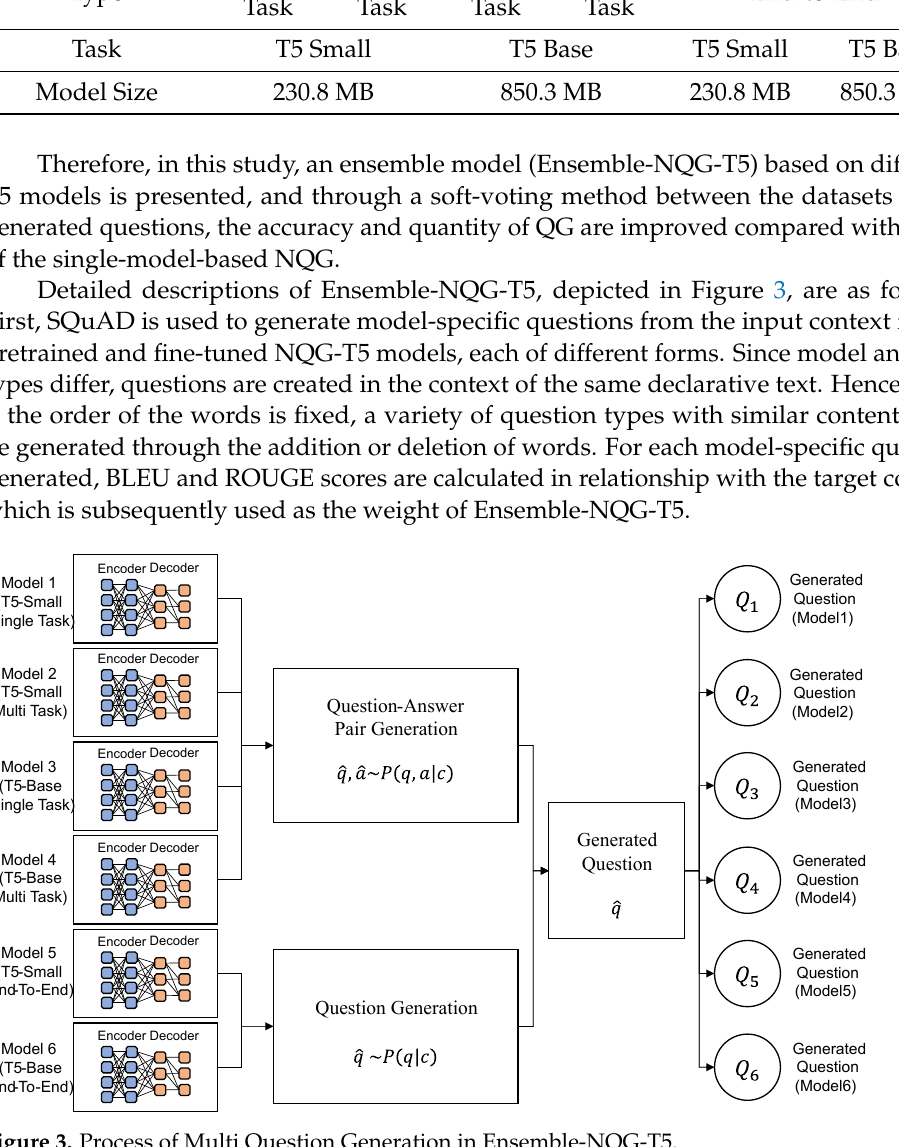
Figure 3. Process of Multi Question Generation in